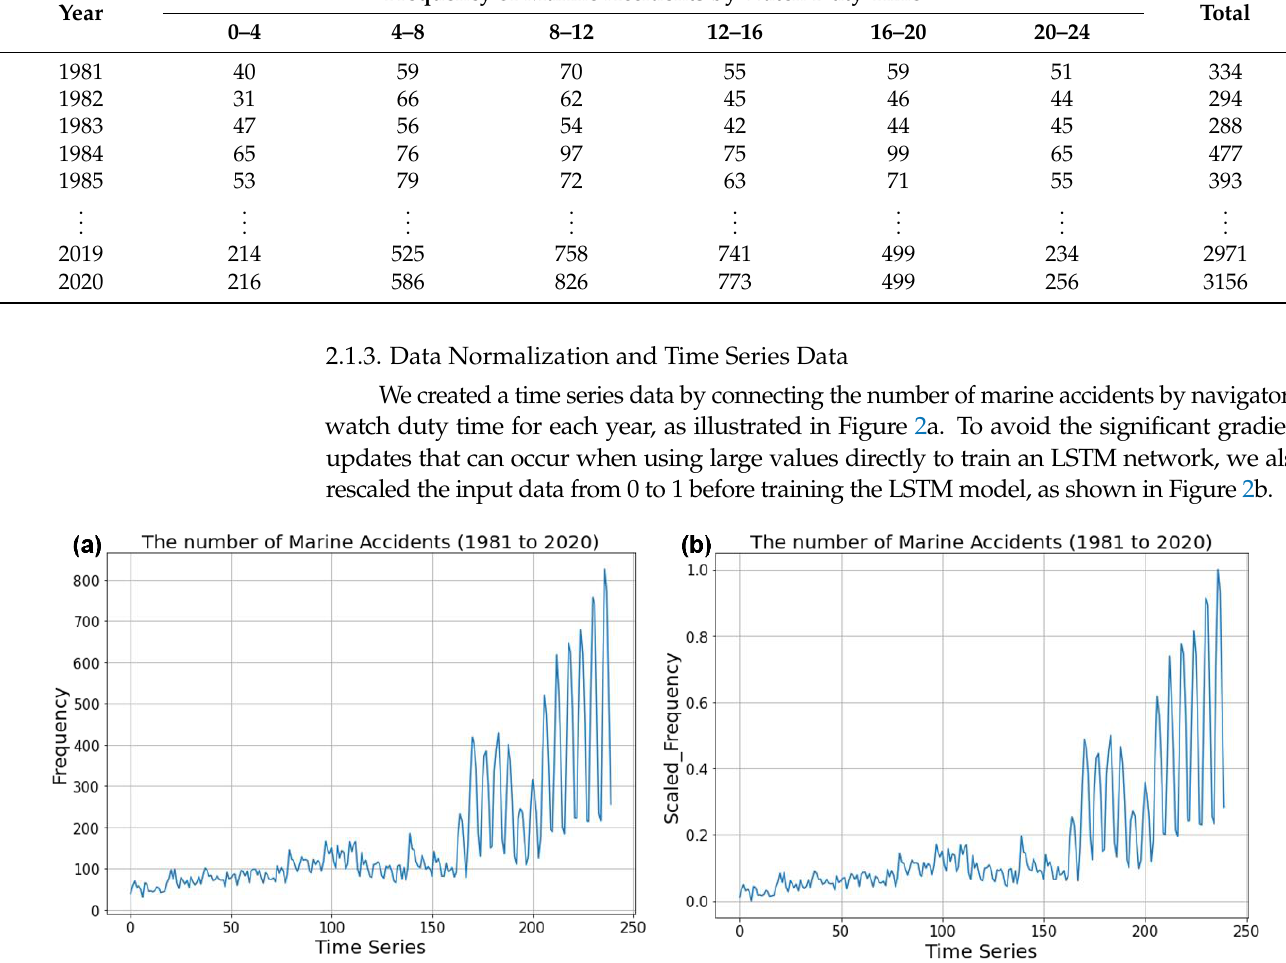
Table 2. Sample of processed data.